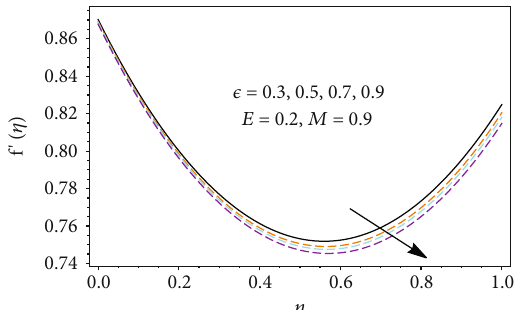
Figure 6: Illustration of the in fl uence of the input factor Q < 0 on θ ð η Þ .